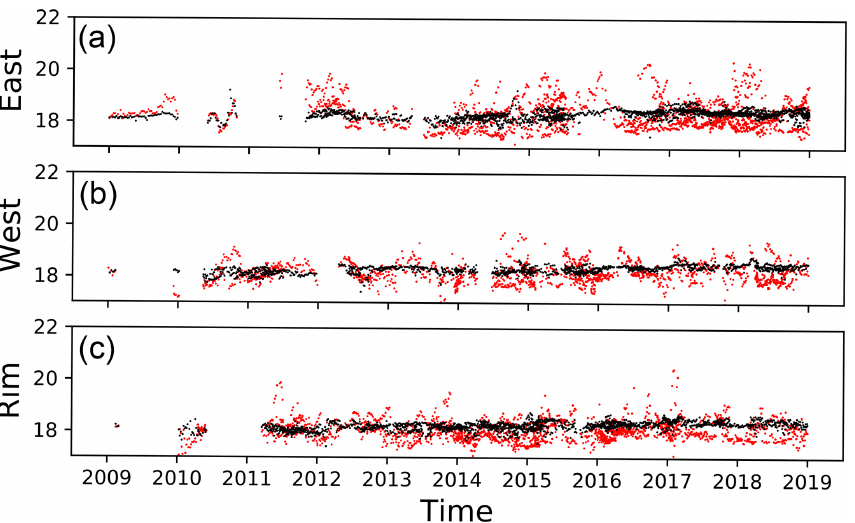
Figure 9. Time series of model salinity at 25m sampled over the three regions shown in Fig. 1: (a) east, (b) west and (c) rim. Black dots indicate data from Argo floats; red dots indicate data from model